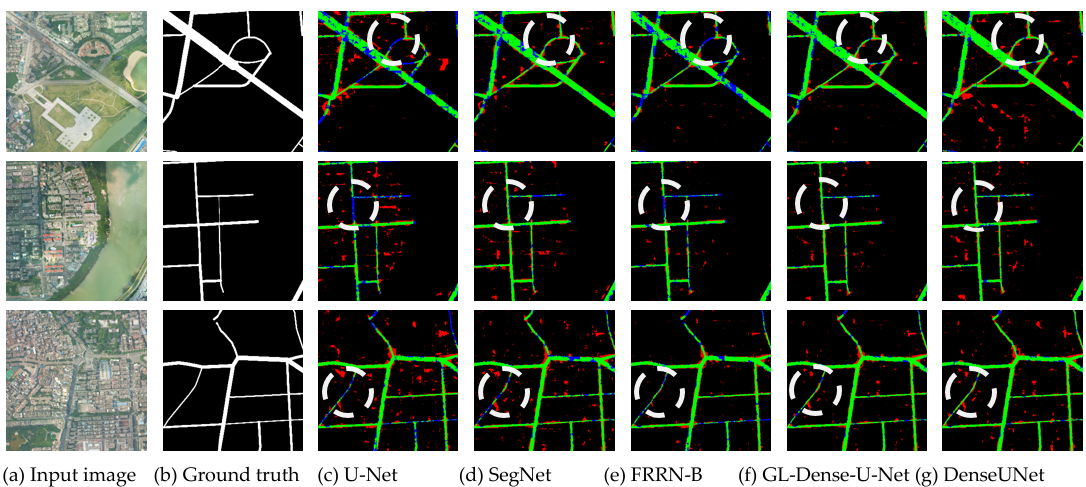
Figure 7. Images of the original actual color composite image are displayed and classified in three regions using deep learning methods. True positive (TP), false negative (FN) and false positive (FP) were marked as green, blue, and red, respectively. The white dotted line in the images is enlarged for close-up inspection in Figure 7.